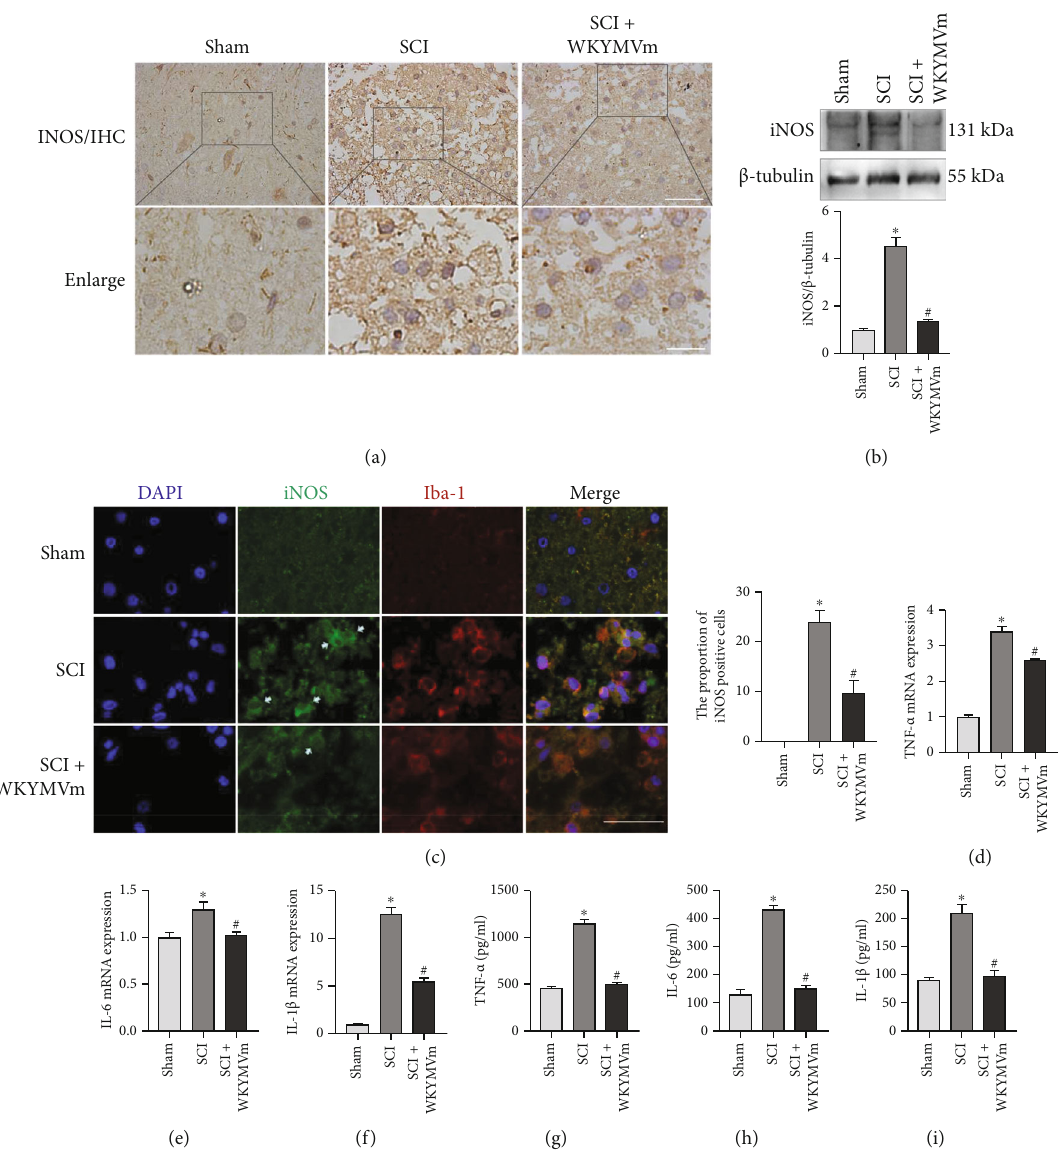
Figure 7: WKYMVm attenuated M1 polarization and improved the in fl ammatory microenvironment after SCI. (a) Immunohistochemical displayed the iNOS signal in sections from the tissue at 72h after SCI. Scale bars: 50 μ m (INOS/IHC); 20 μ m (enlarge). (b) Western blots and quantitative data for iNOS protein expression in sections from the tissue at 72 h after SCI. (c) Double immuno fl uorescence staining and quantitative data for iNOS- (green) and Iba-1- (red) positive microglia of sections from the tissue at 72 h after SCI. White arrows mark positive cells. Scale bar: 50 μ m. (d – f) The levels of TNF- α , IL-6, and IL-1 β mRNA in tissue from SCI rats treated with or without WKYMVm were measured by RT-PCR at 72h. (g – i) Quanti fi cation analysis of the production of TNF- α , IL-6, and IL-1 β in the spinal cord after SCI by ELISA. ∗ p < 0 : 05 vs. the sham group; # p < 0 : 05 vs. the SCI